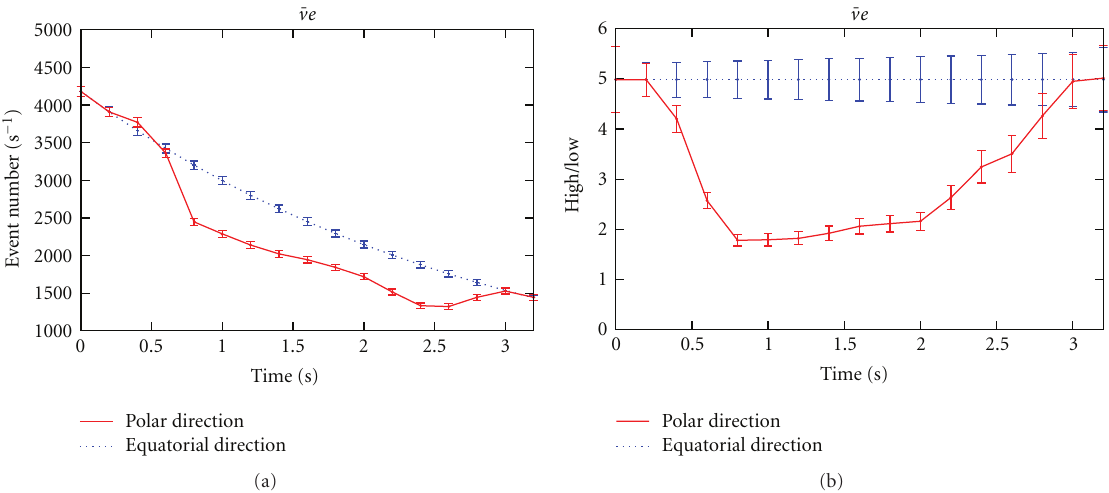
Figure 28: Same as Figure 27 but for the expected event number of ν e (left panel) in the SK as a function of the time. The solid line (red line) and the the dotted line (blue line) are for the polar and the equatorial directions, respectively. The supernova is assumed to be located at the distance of 10 kpc. The error bars represent the 1 σ statistical errors only. Right panel is for the ratio of high-to-low-energy events which can be a useful quantity to characterize the change (dip in the right panel) of neutrino signals by the shock e ff ect (see [306] for